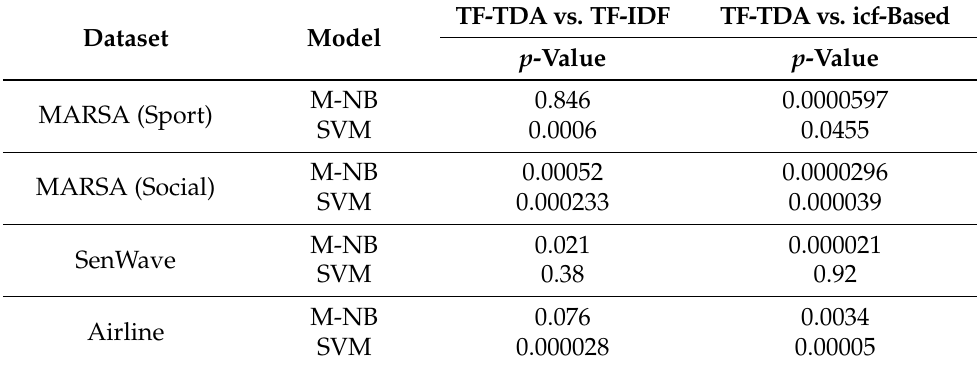
Table 10. Statistical test